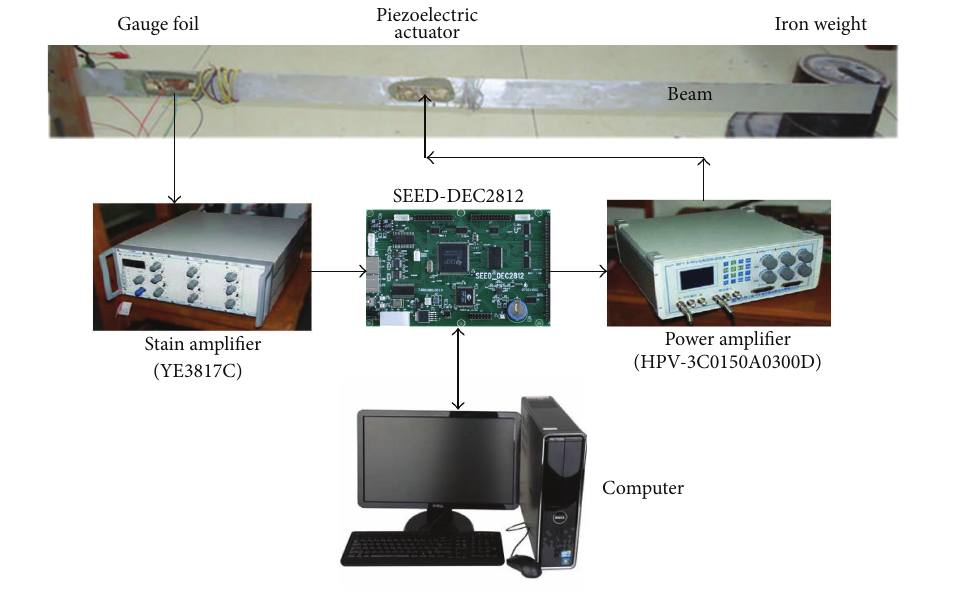
Figure 6: Experimental setup.